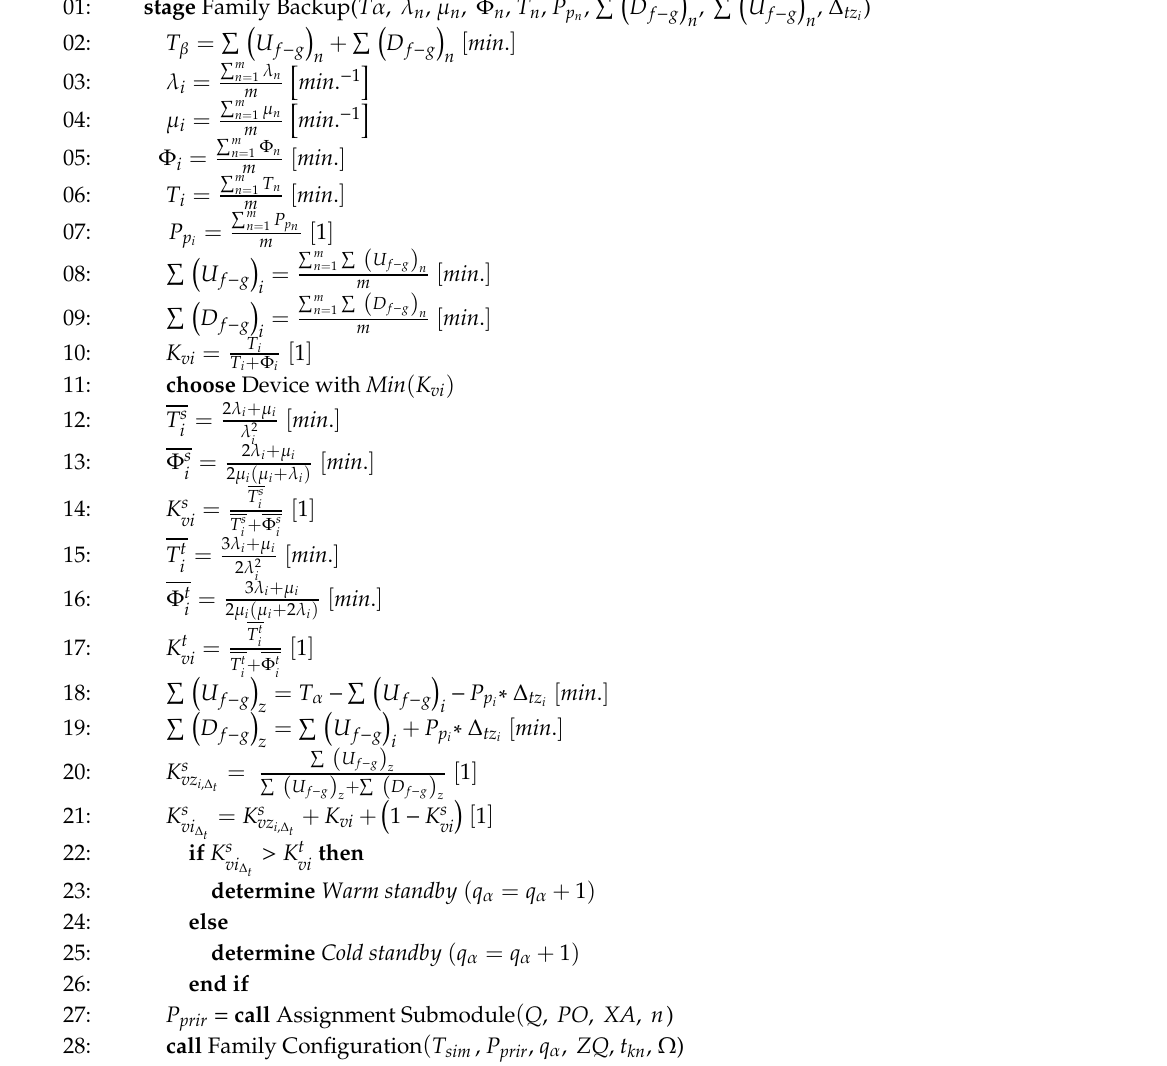
Algorithm 6 Creating the Product Family and the Resource Availability—Part 3 01: stage Family Backup( T α , λ n , µ n , Φ n , T n , P p